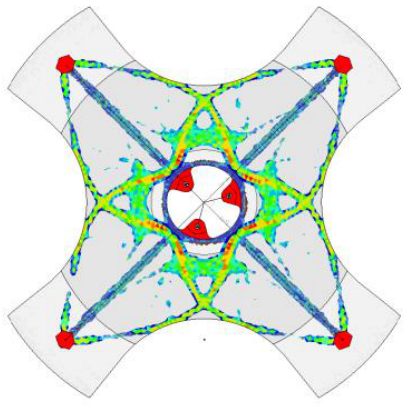
Figure 16. Top design space (gray shaded region) and initial topology optimization result.